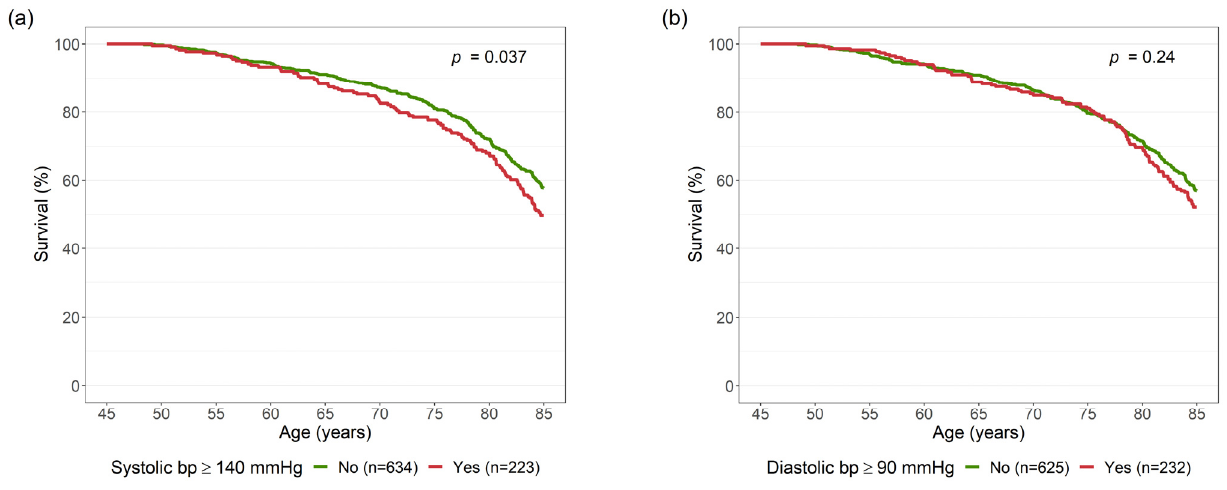
Figure A1. Survival curves by high systolic bp ( a ) and high diastolic bp ( b ). Those who reported use of bp medication are included in the yes categories. The Tromsø Study 1979–2019. bp: blood pressure.